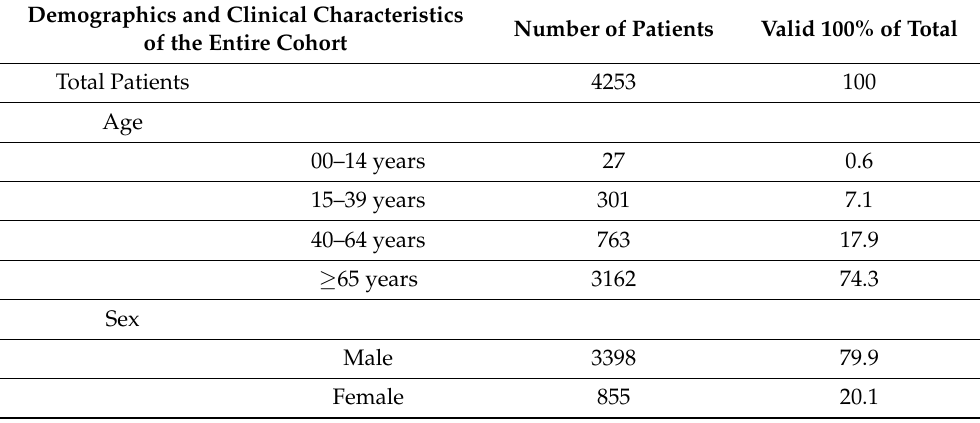
Table 1. Demographics and Clinical characteristics of the entire cohort of Cutaneous Soft Tissue Sarcoma (CSTS) of Head and